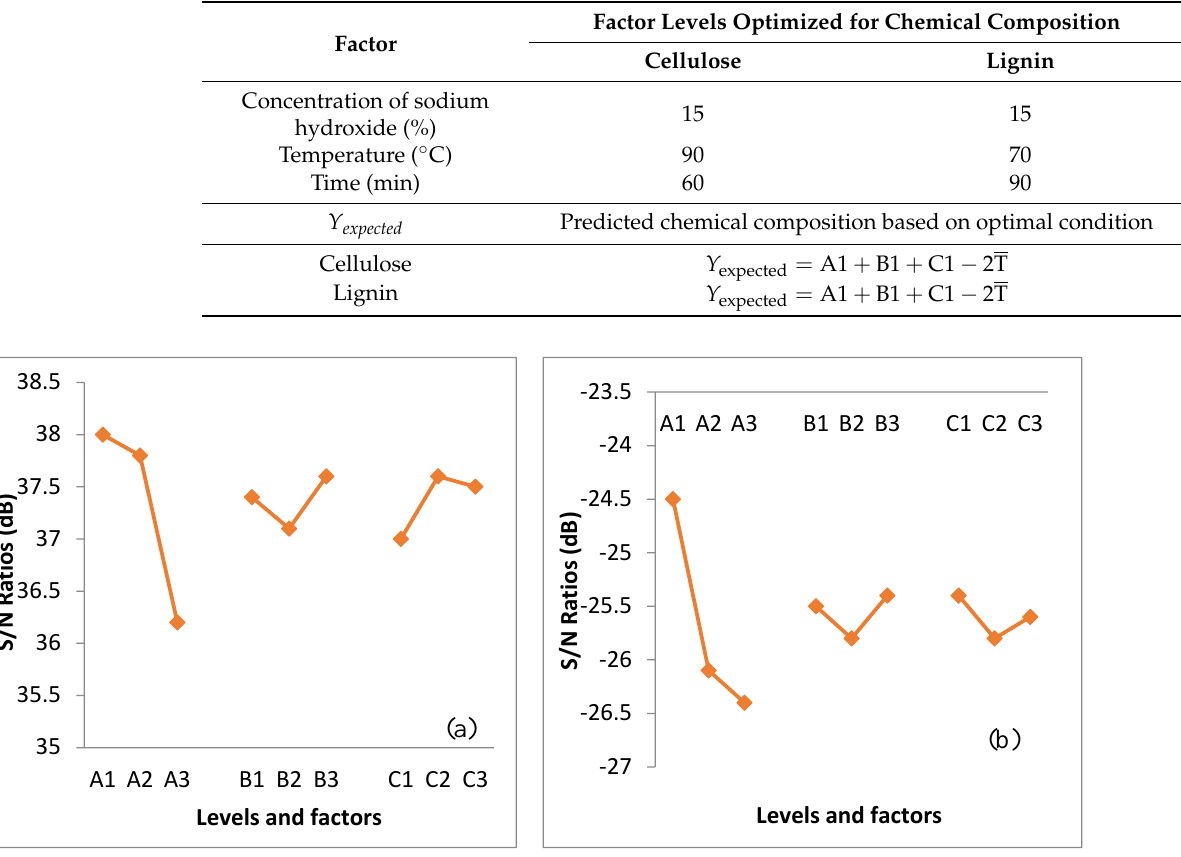
Figure 1. S/N ratio for various factors (A – C, Table 1) and levels (1 – 3, Table 1): ( a ) cellulose content; ( b ) lignin content. Peak values of the S/N ratio indicates optimum conditions. Table 4. Optimized factor levels for the chemical composition of cellulose and lignin.